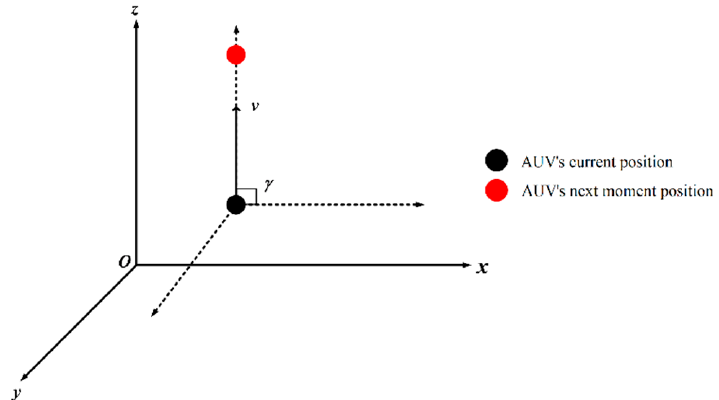
Figure 6. Schematic diagram of small angle navigation in vertical direction of AUV.